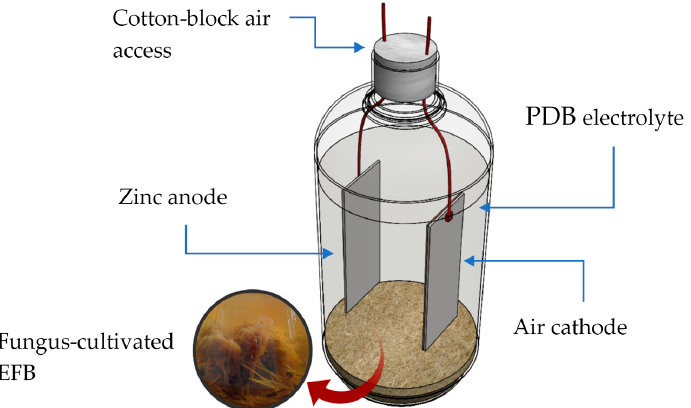
Figure 1. Schematic illustration of the fungal biofuel cell. Note that the air cathode is totally submerged in the potato dextrose broth (PDB) electrolyte.